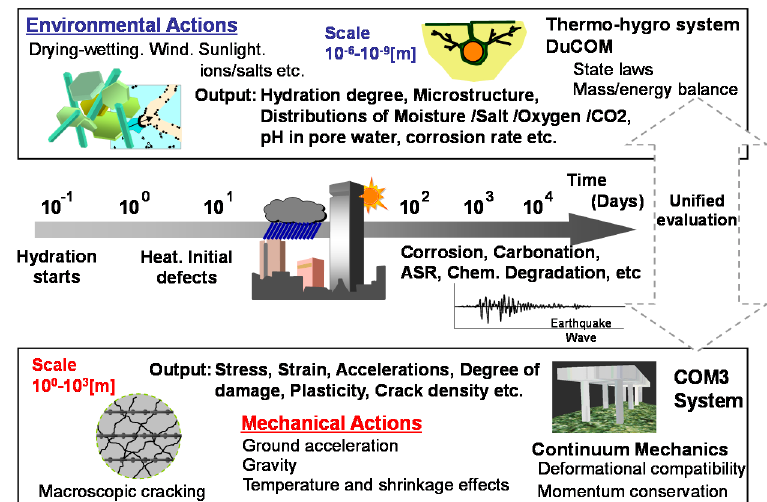
Figure 1. Multiscale and multi-physical modelling to simulate time-dependent concrete performance.